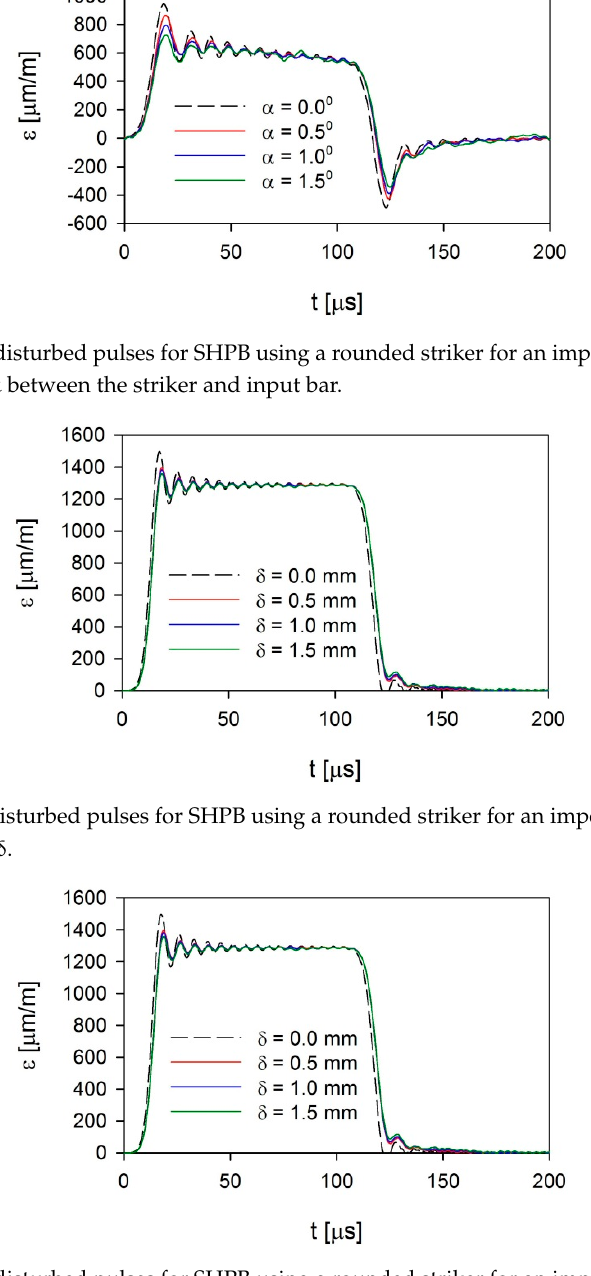
Figure 13. Reflected disturbed pulses for SHPB using a rounded striker for an imperfection in the form of neutral axis offset δ .